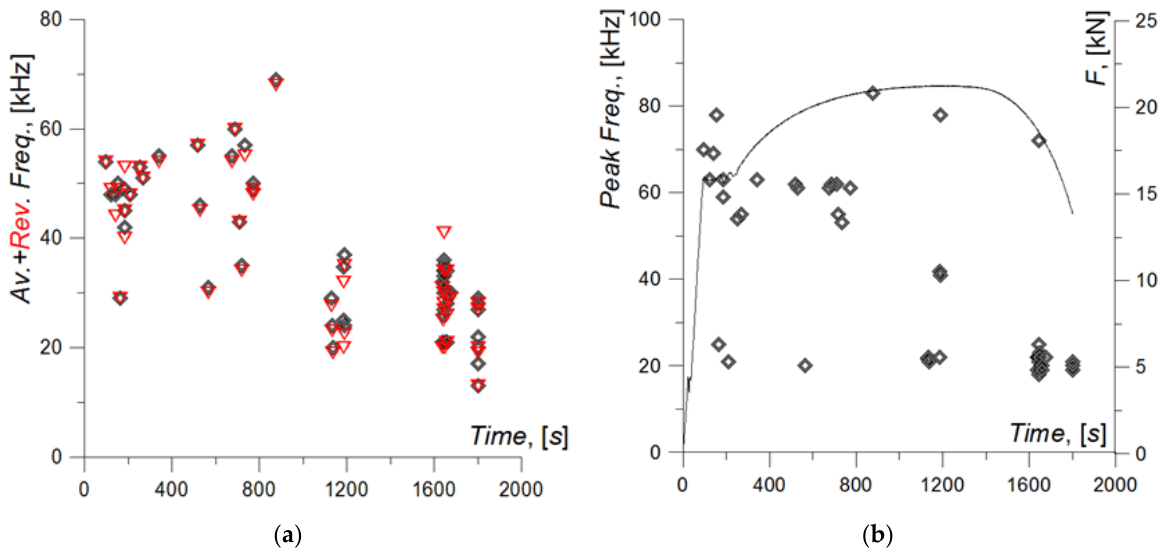
Figure 13. Frequency characteristics of the AE signal recorded during specimen loading: ( a ) Average (black symbol) and Rev. Freq. (red symbol); ( b ) Peak